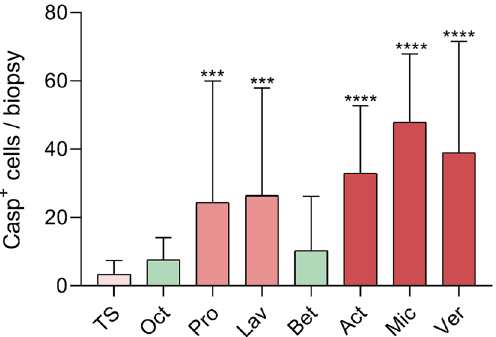
Figure 4. Numbers of caspase-3 + cells in wounded human ex vivo tissue upon wound gel treatment. Shown is the number of caspase-3 + cells in treated skin biopsies counted within 4 fields of view (FOV) per biopsy (tape-stripped (TS), untreated control and treated with Oct, Pro, Lav, Bet, Act, Mic or Ver) of six donors. FOVs are assessed as technical replicates and data is presented as a mean ± standard deviation. Two-way analysis of